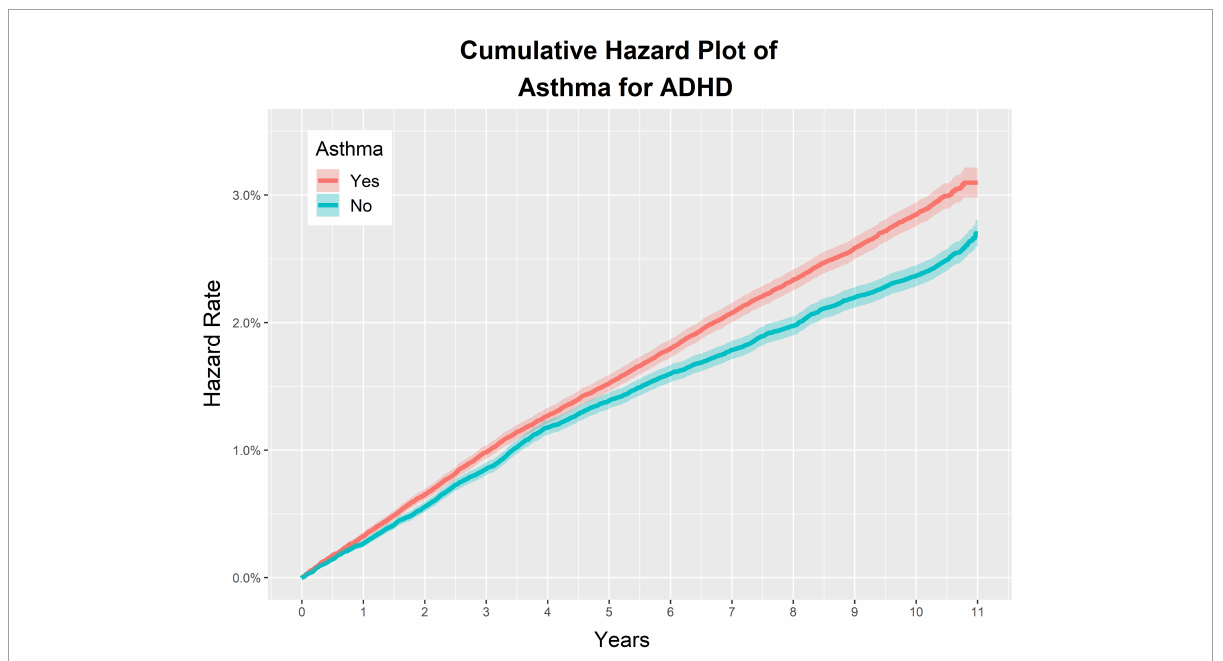
FIGURE2 Study 1. Overall cumulative hazard rate for ADHD in the asthma group and the non-asthma